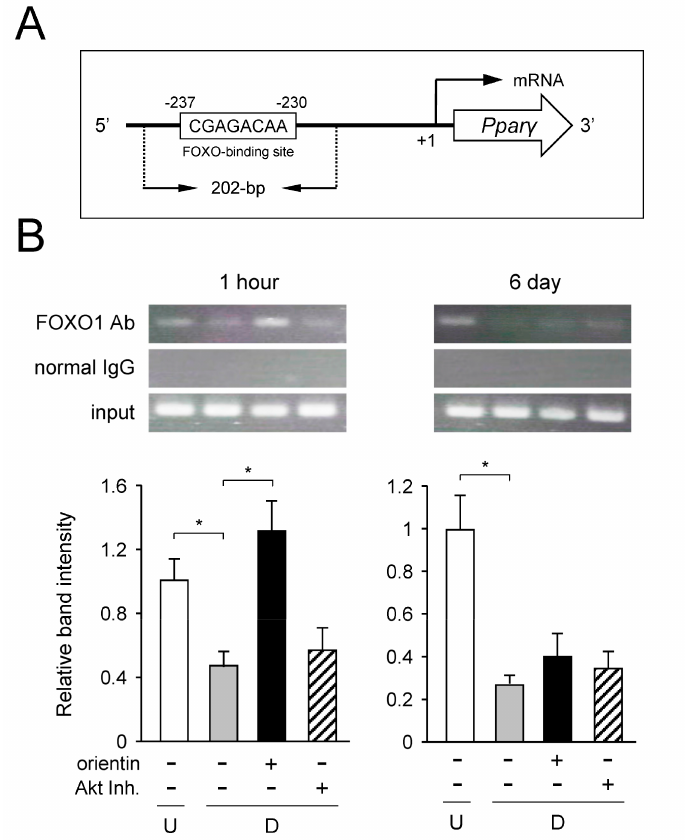
Figure 8. Increased binding of FOXO1 to Ppar γ promoter by orientin. ( A ) Schematic representation of the FOXO-binding site in the mouse Ppar γ promoter. The amplicon obtained from the ChIP assay was also shown; ( B ) ChIP assay of the FOXO-binding site in mouse Ppar γ promoter in 3T3-L1 cells. Undifferentiated cells (U; white columns) were caused to differentiate into adipocytes (D; gray columns) for 1 h or 6 days in medium with orientin (50 µ M; black columns), or Akt inhibitor X (10 µ M, Akt Inh.; hatched columns). The input control (input) indicates a small aliquot from prior to immunoprecipitation. Data represent as the mean ± S.D. * p < 0.01, as shown by the brackets. Ab: